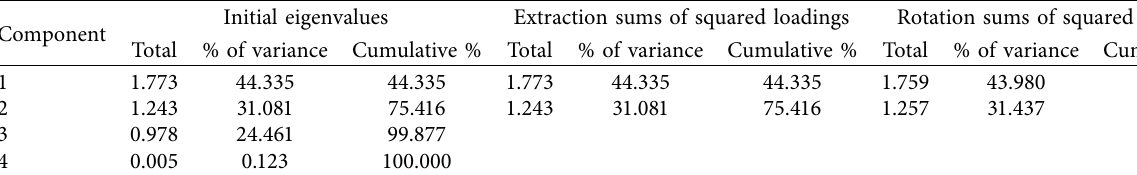
Table 10: Total variance explained.